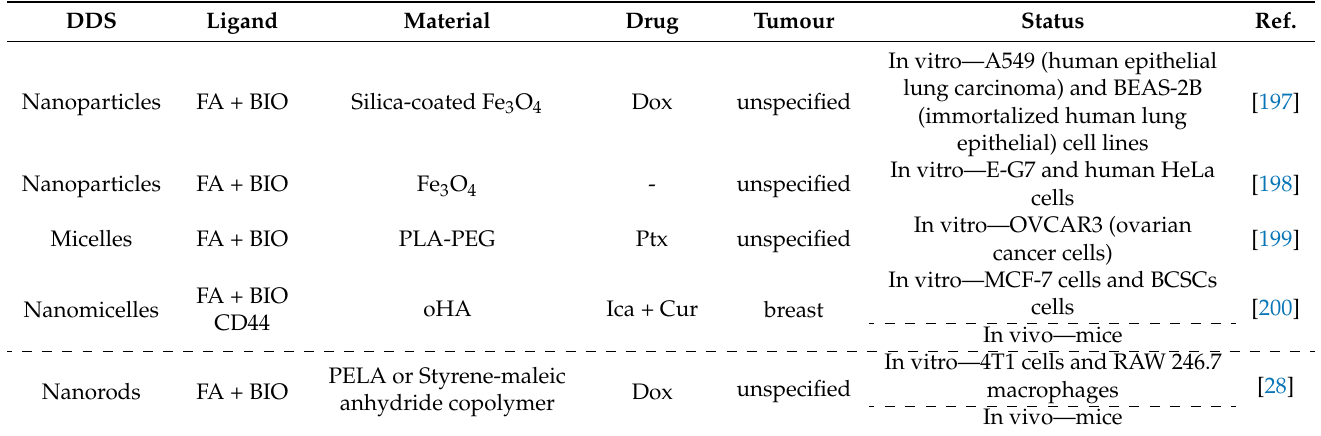
Table 9. The examples of nanoparticles targeted with folic acid and